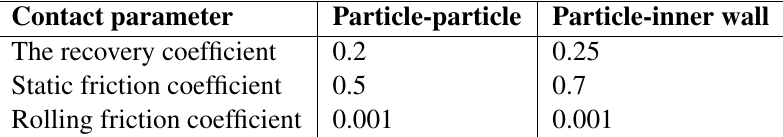
Table 2 Particle contact parameter